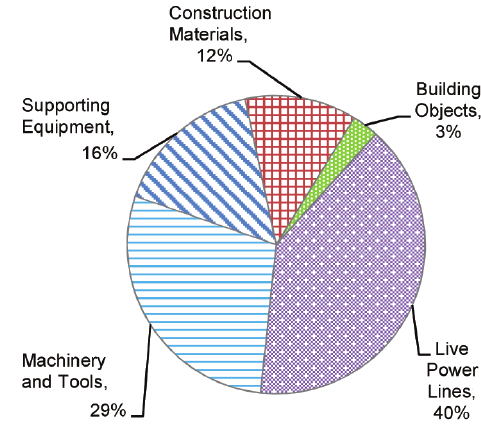
Fig. 2. Immediate causes of electrical deaths in US construction, 1989–2011 Note: the data source is from Zhao et al .